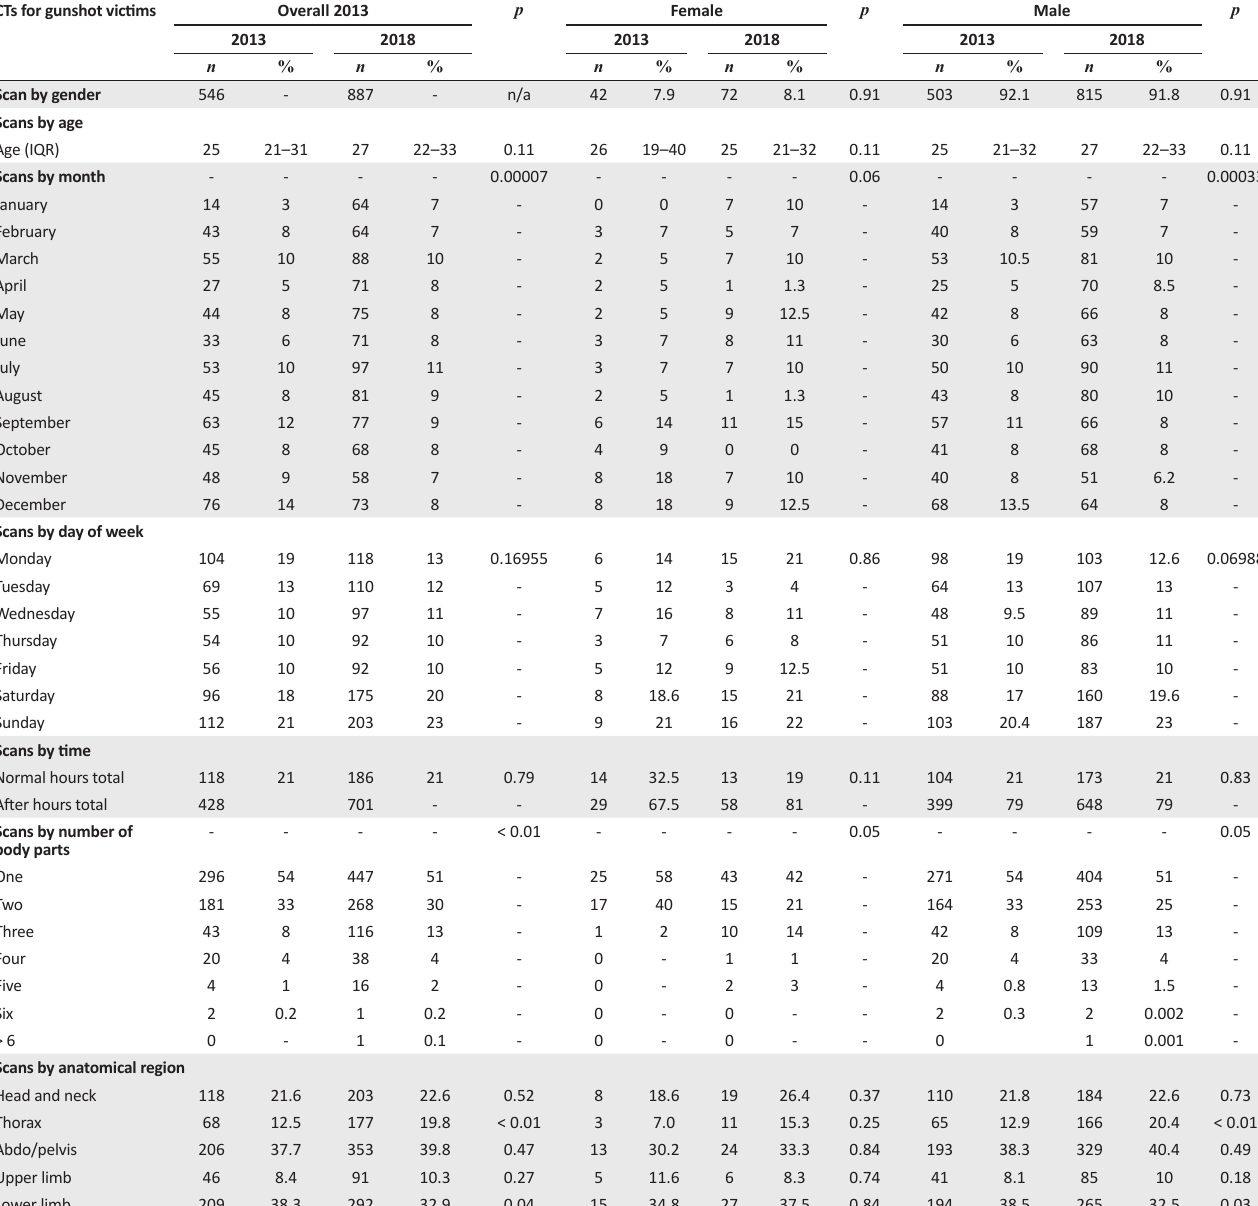
TABLE 3: Computed tomography scans by gunshot victims. CTs for gunshot